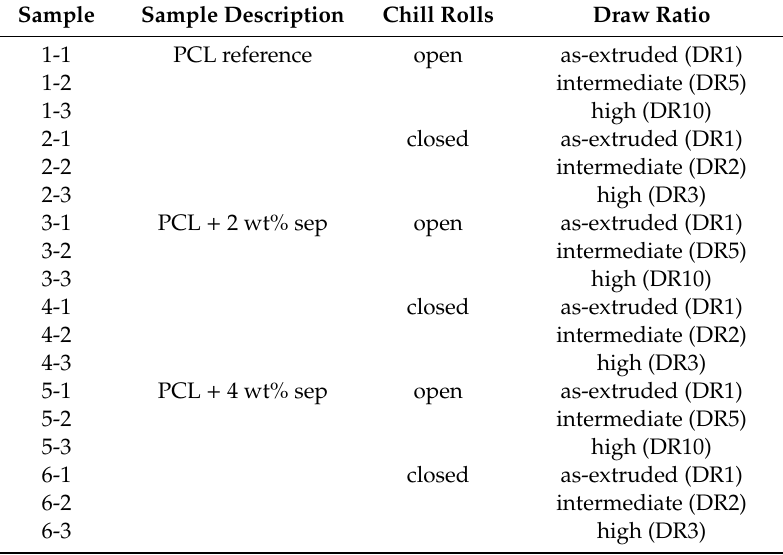
Table 2. Description of the samples and their abbreviations.